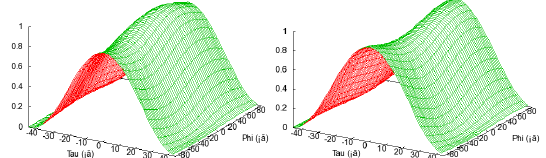
Figure 2. Co-polarization signature of trihedral corner reflector. (Left:Set to be 0.5, Right: Set to be 1.5)